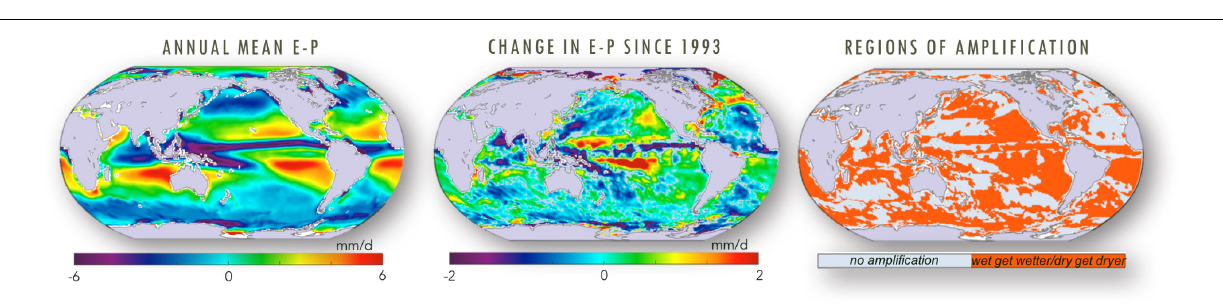
FIGURE 5 | Linking salinity to the global hydrological cycle is one of scientific drivers of satellite SSS. Shown here are mean patterns of the ocean water cycle and its amplification in the last two decades based on the ECCO ocean state estimate. Left: average rates at which freshwater enters (blue) or leaves (red) the ocean via the processes of precipitation (P) and evaporation (E); Middle: trends in E-P; blue (negative) means that the ocean received more freshwater since 1993. Right: Amplification of the ocean water cycle, computed as a slope of the linear regression between the anomalies and trends in E-P. Pattern amplification is shown as orange, otherwise is shaded gray. In many ocean regions, pattern amplification follows the wet gets wetter/dry gets drier paradigm, as more freshwater is brought to wet regions (e.g., blue colors match blue in the tropics), or more freshwater is removed from dry regions (e.g., red colors match red in the United States west coast. If averaged over the globe, the ocean water cycle has amplified by 5% since 1993. See Vinogradova and Ponte (2017) for